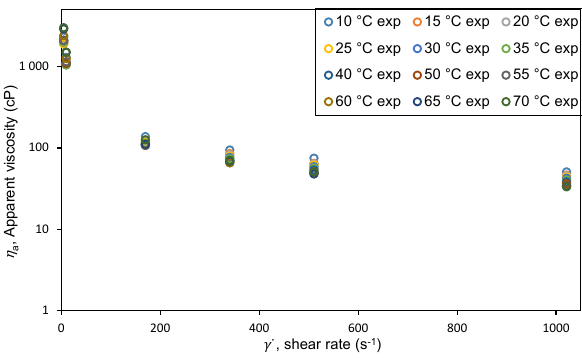
Figure 6: Comparison between the experimental shear stress and the data predicted by the Herschel-Bulkley model (including the intermediate rheological parameters). Dashed line: graph diagonal; solid line: linear trend of τ predicted vs. τ exp . n a (4.12 × 10 −4 ∘ C −1 ), n 0 (6.47 × 10 −1 ), τ 0 i (1.12 × 10 2 dyn/cm 2 ), and τ 0 a (8.00 × 10 −2 dyn/(cm 2 · ∘ C)).